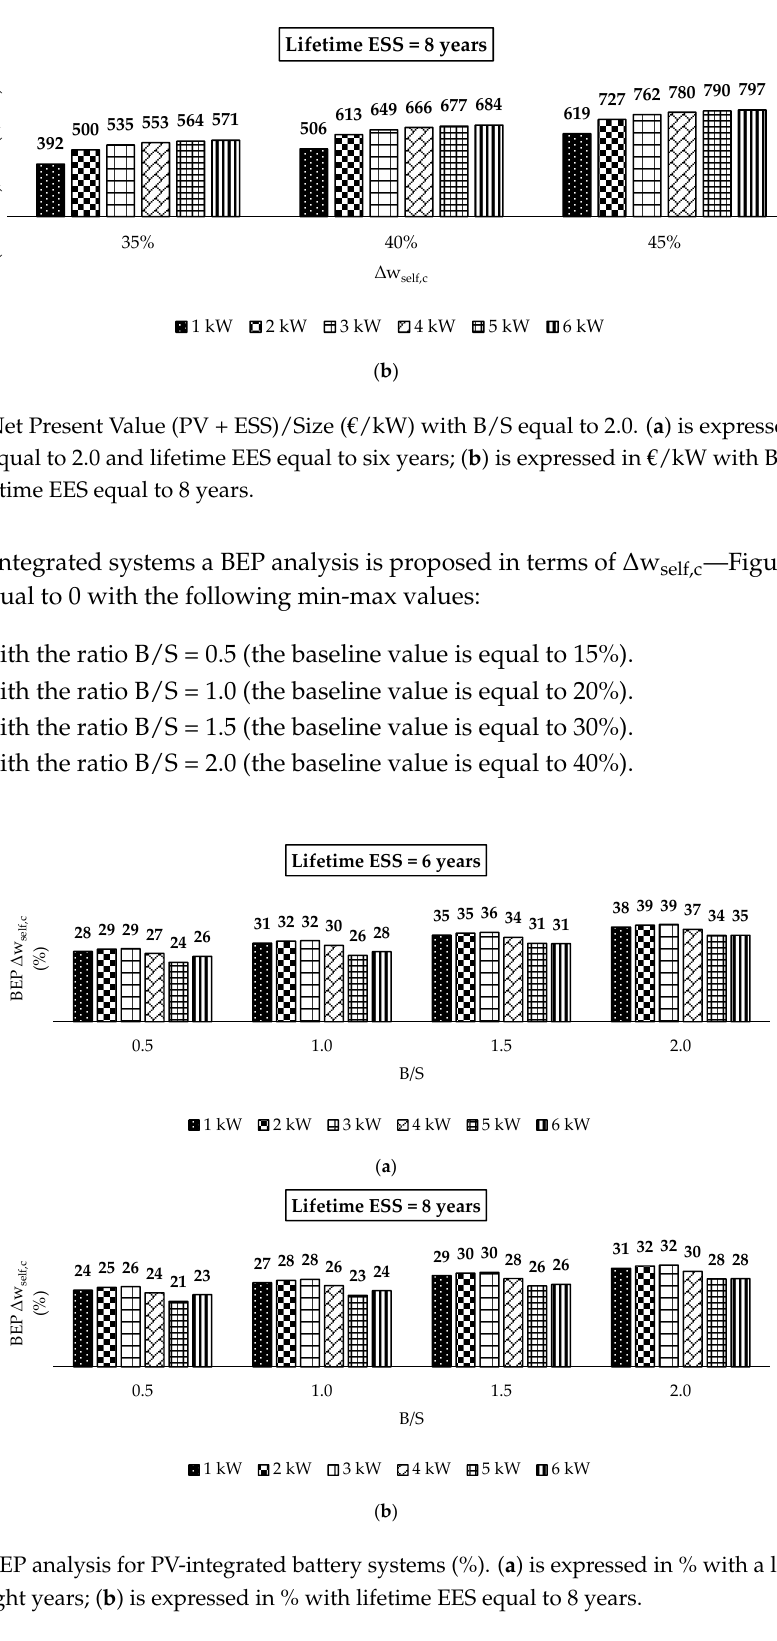
Figure 4. BEP analysis for PV-integrated battery systems (%). ( a ) is expressed in % with a lifetime EES equal to eight years; ( b ) is expressed in % with lifetime EES equal to 8